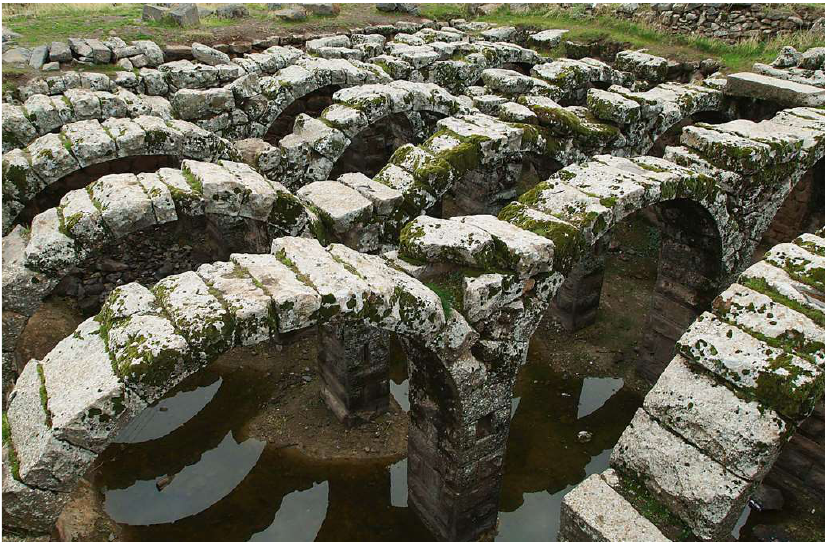
Figure 6. Cistern in front of the temple of Zeus Megistos at Kanatha. ©James Gordon, cc-by-2.0 [84].